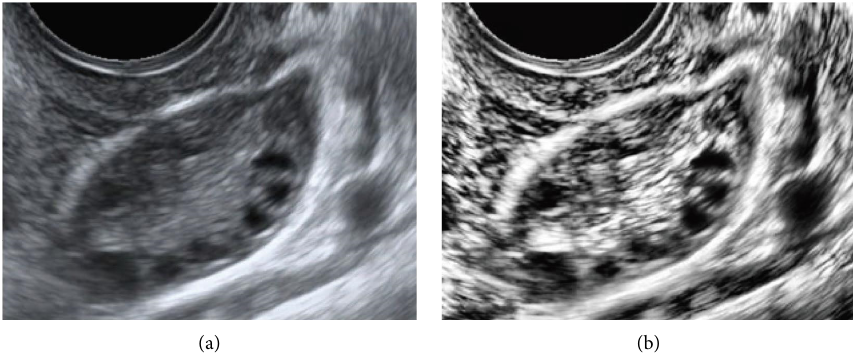
Figure 5: Clinical view of ultrasound ovary image before (a) and after (b) applied adaptive histogram equalization.